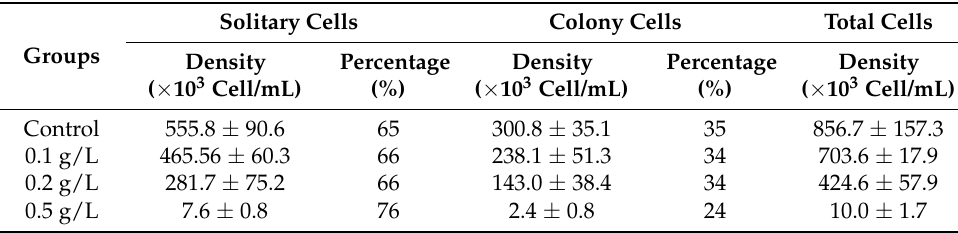
Table 1. Densities and percentages of total cell abundance for solitary cells and colonial cells at 10th day after addition of various concentrations of MC. Solitary Cells Colony Cells Total Groups